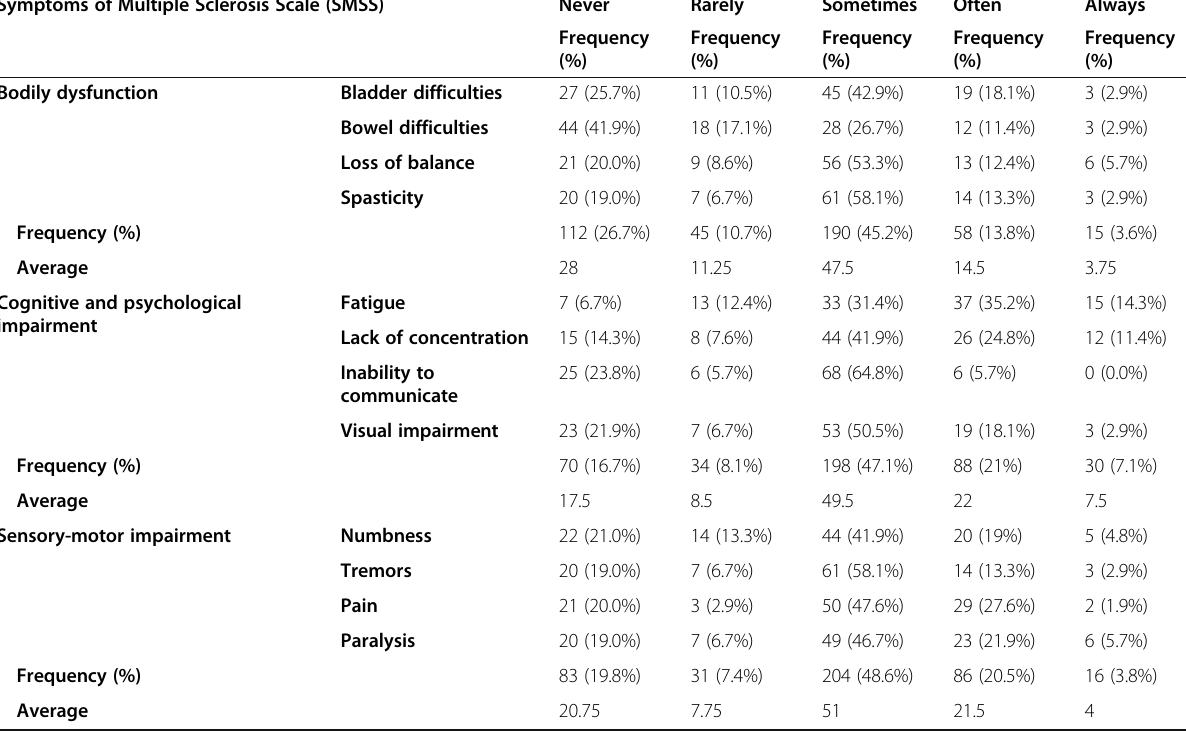
Table 5 Symptoms of Multiple Sclerosis Scale (SMSS) Symptoms of Multiple Sclerosis Scale